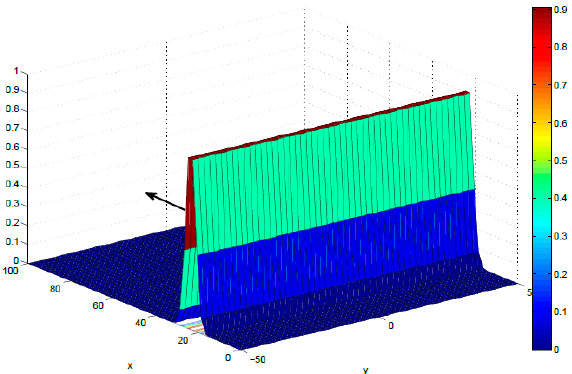
Figure 3. Surface graph of the input function corresponding to a light signal of the color Y = 0